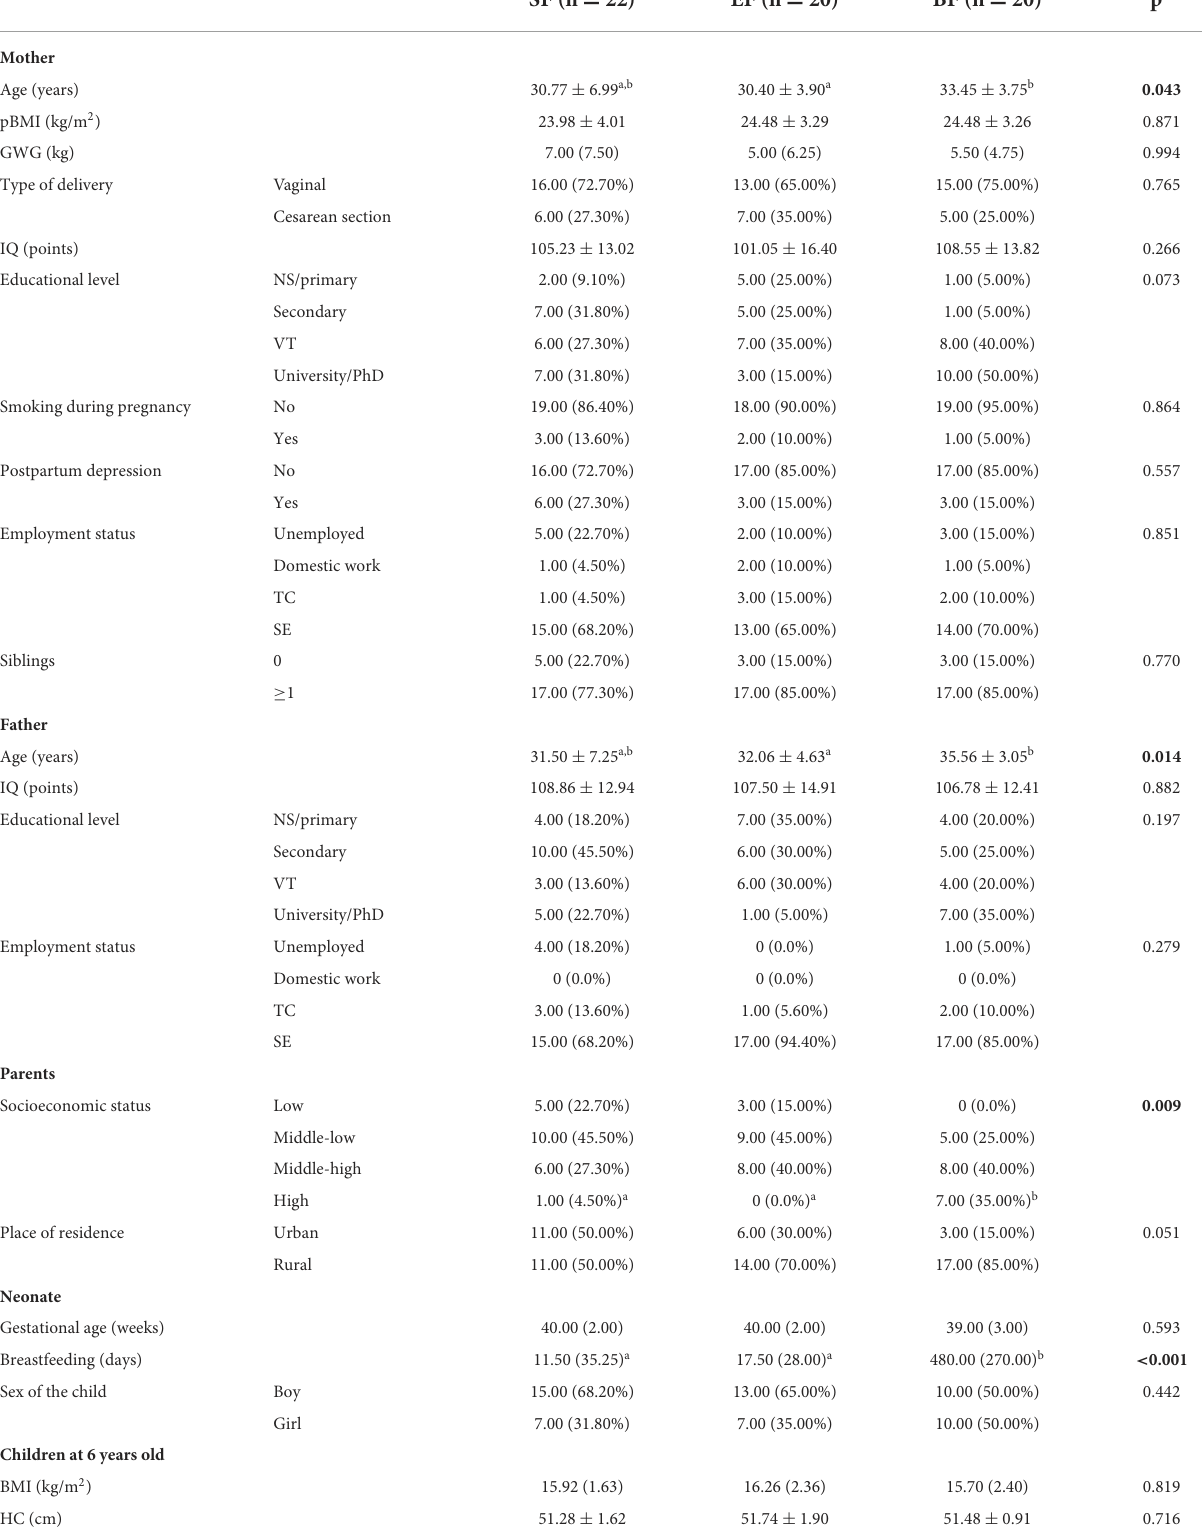
TABLE 1 Children’s and parents’ baseline characteristics at 6 years old depending on their type of diet during the first 18 months of life 1